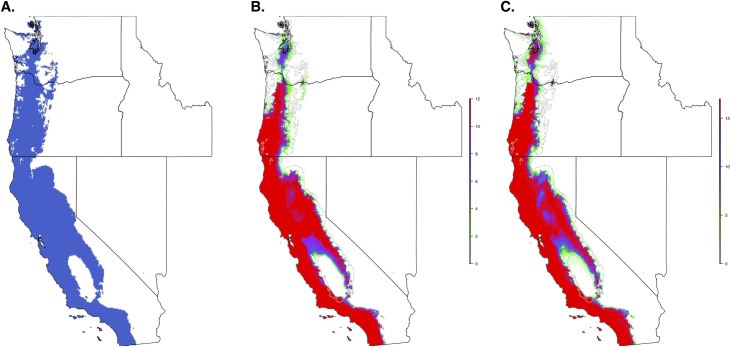
Current climate niche of I. pacificus based on a 95% sensitivity (A) and number of future climate scenarios (CMIP5) predicting suitable habitat across the I. pacificus climate niche model in 2050, based on an RCP 6.0 (B) and RCP 8.5 (C) and 95% threshold.The grey line in panels B and C indicates outline of current climate niche.